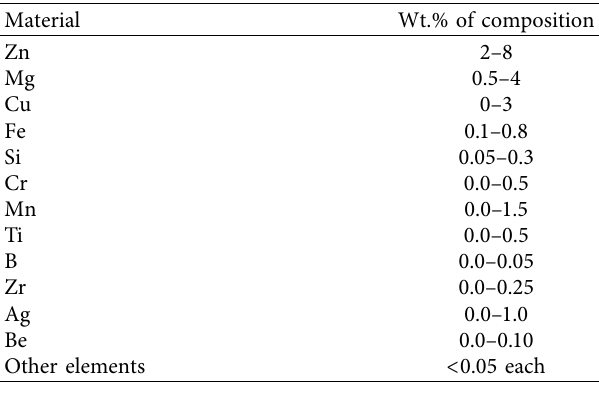
Table 1: Chemical composition range of Al-Zn-Mg alloys.